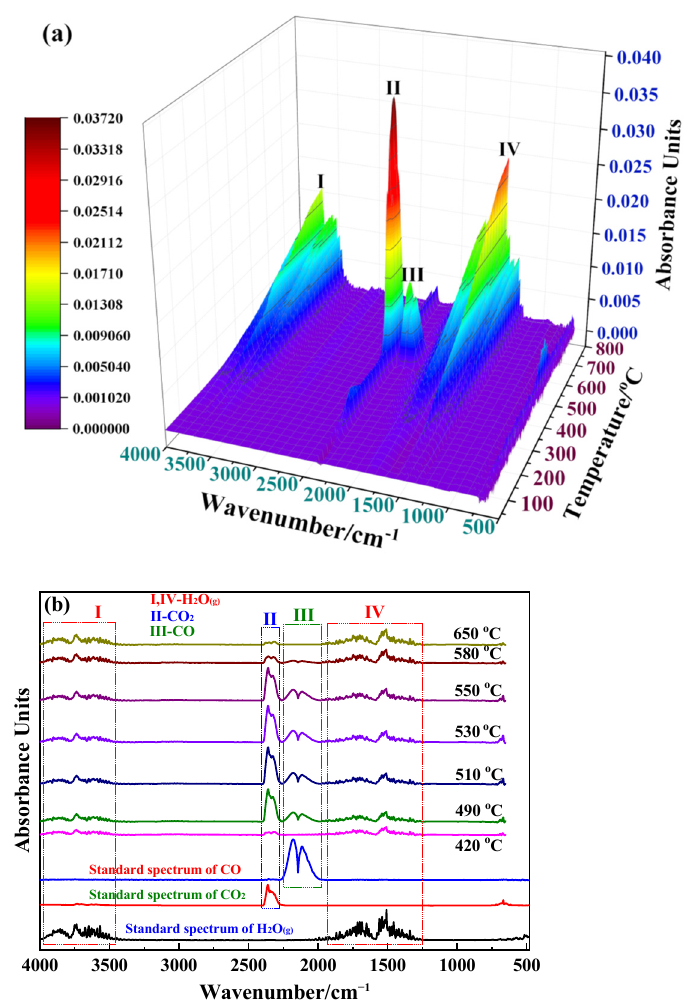
Figure 5. ( a ) 3D and ( b ) 2D FTIR spectra of the gaseous